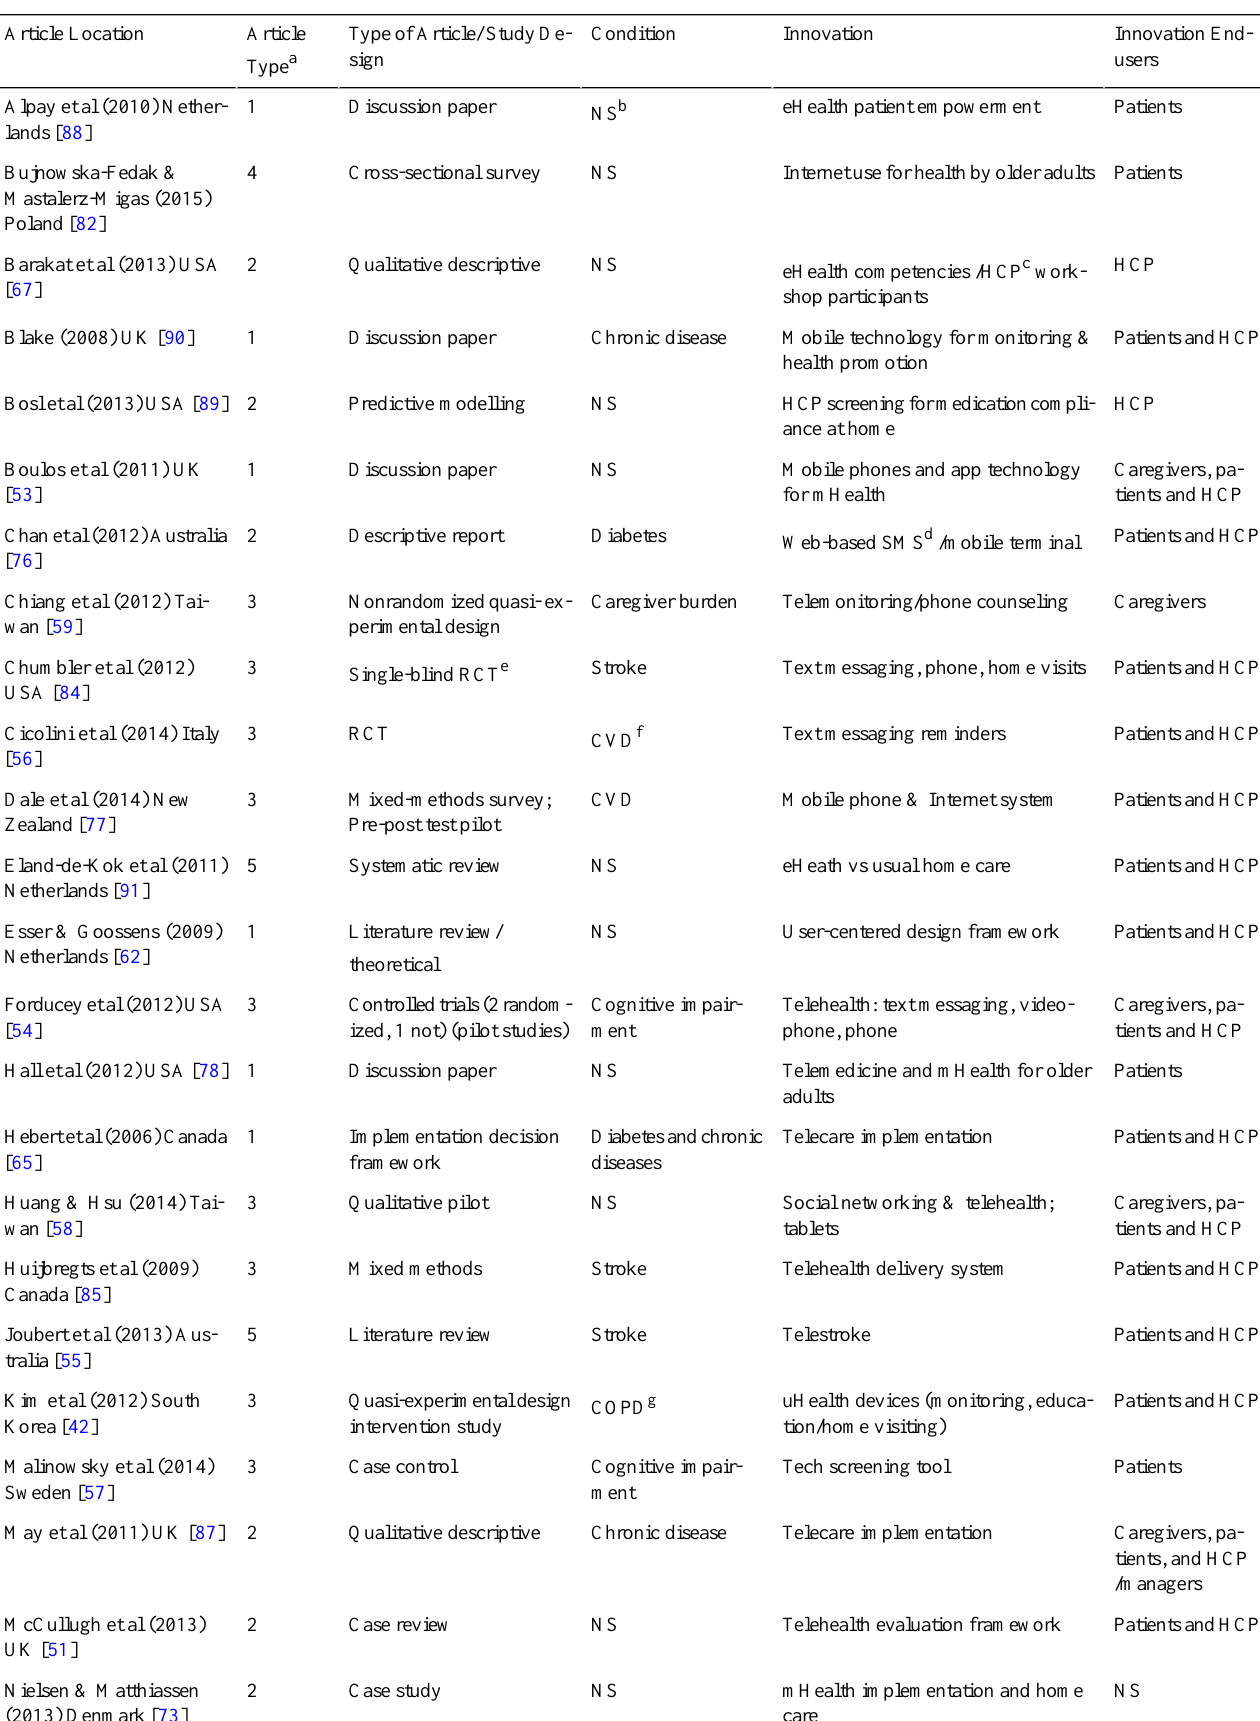
Table 1. Review article